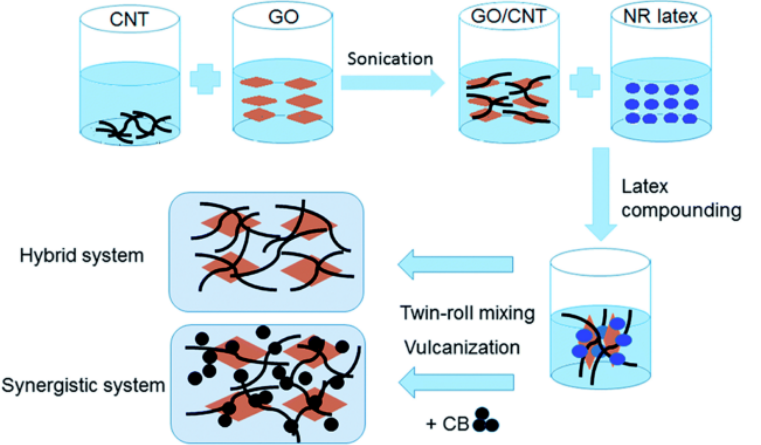
Figure 7. Latex mixing process utilized to create the GO/CNT/NR composites is depicted schemati- cally [29].